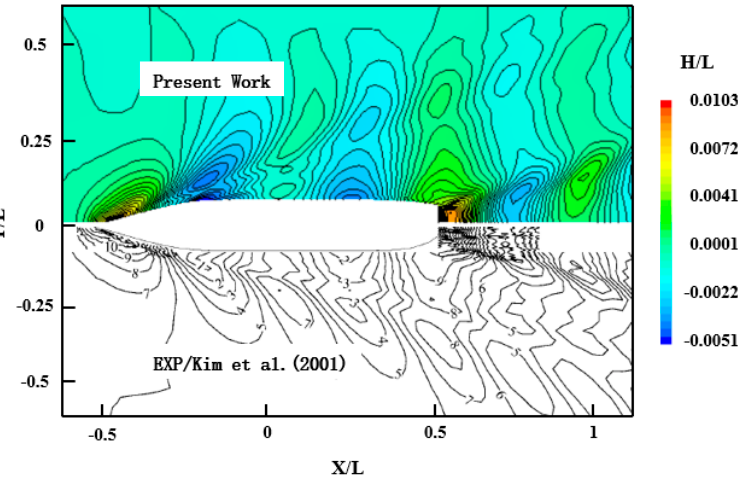
Figure 12. The wave pattern at F n = 0.26 [49].